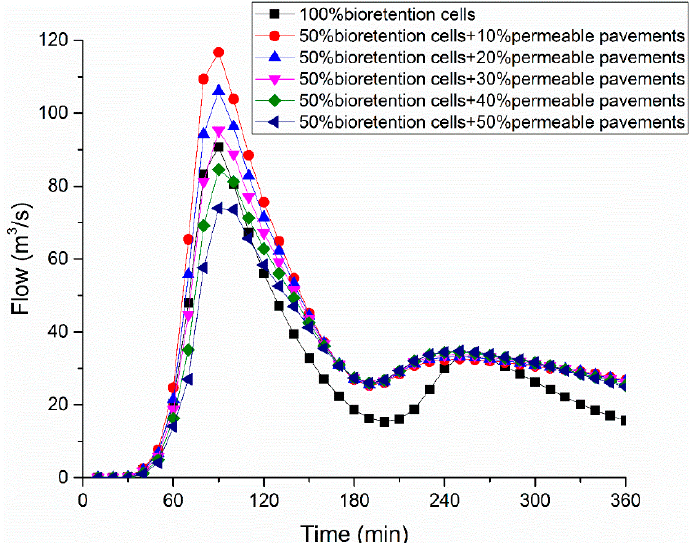
Figure 12. Peak value of outlet flow with different construction proportion of LID controls ( p = 10 rainfall).